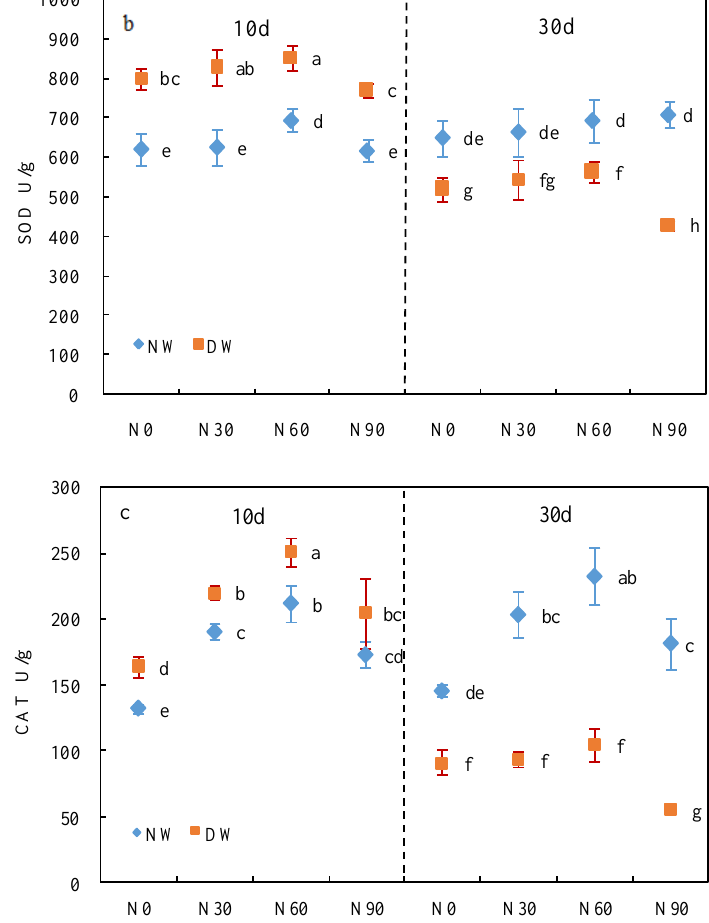
Figure 2. ( a ) Effect of drought stress and nitrogen deposition on POD activity; ( b ) effect of drought stress and nitrogen deposition on SOD activity; ( c ) effect of drought stress and nitrogen deposition on CAT activity. Water supply treatments: normal water supply (NW) or drought stress (DW) for 10 d or 30 d. Nitrogen deposition treatments: control (N0, 0 kg · hm − 2 year − 1 ), low nitrogen deposition